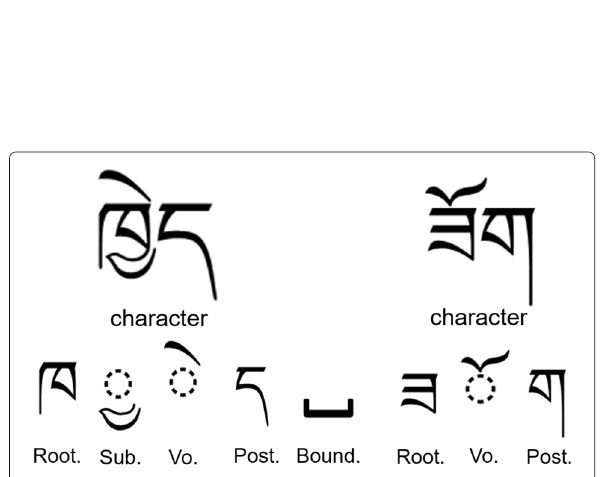
Fig. 3 Segmenting characters to subcharacter units